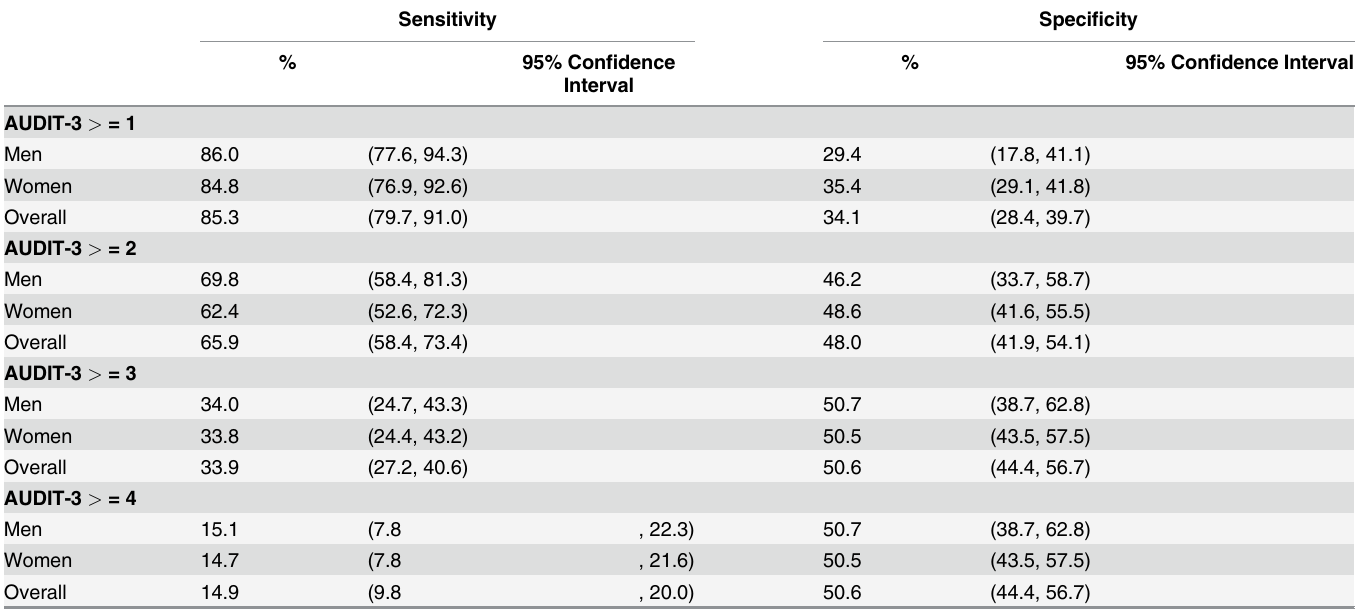
Table 4. Sensitivity and Speci fi city of Cut-offs for AUDIT-3 to the full AUDIT *